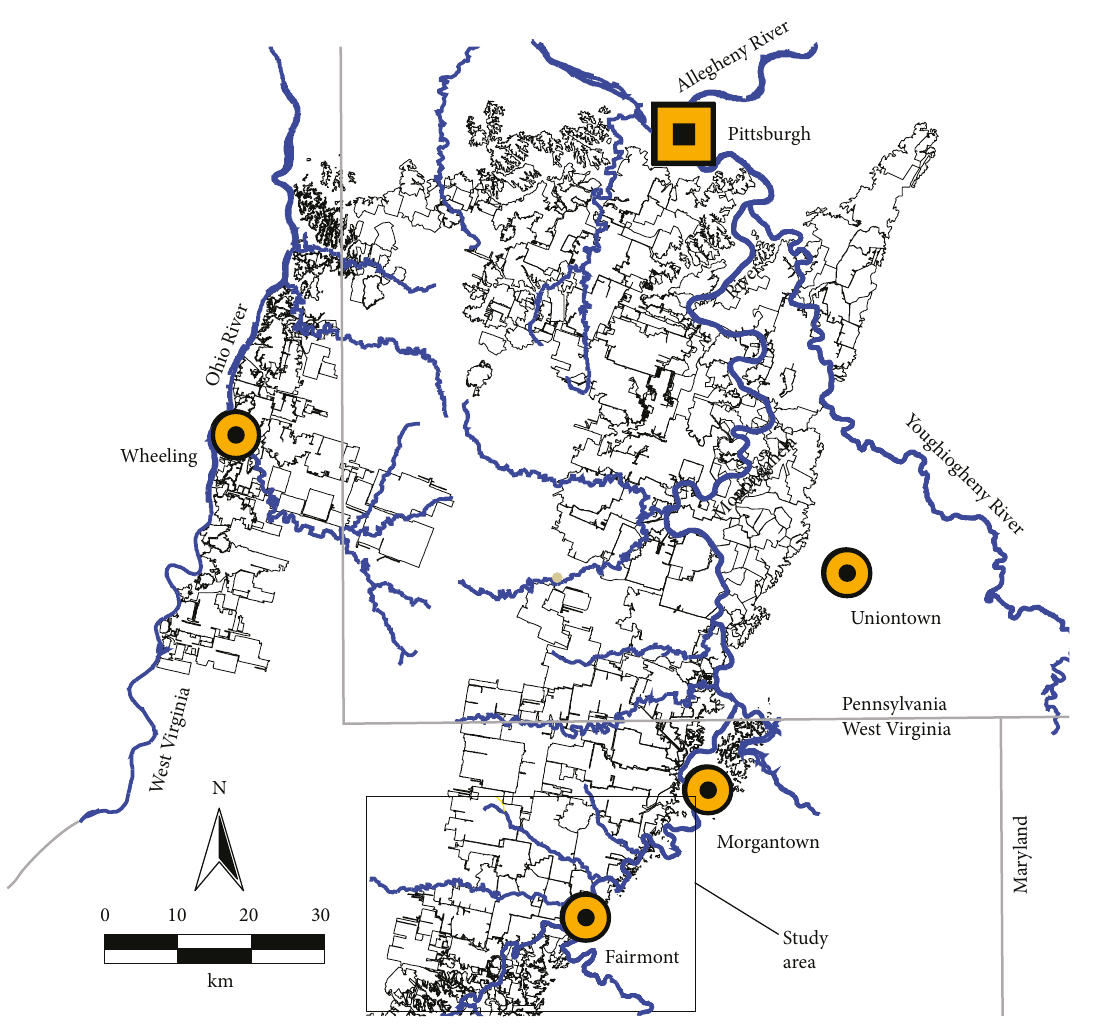
Figure 1: Location of study area in Pittsburgh coal bituminous basin, WV-PA-OH,